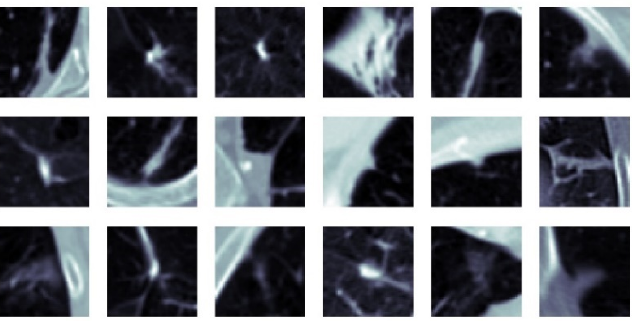
Figure 28. SFMPF model based on Gabor image—missed non-nodules (FP).